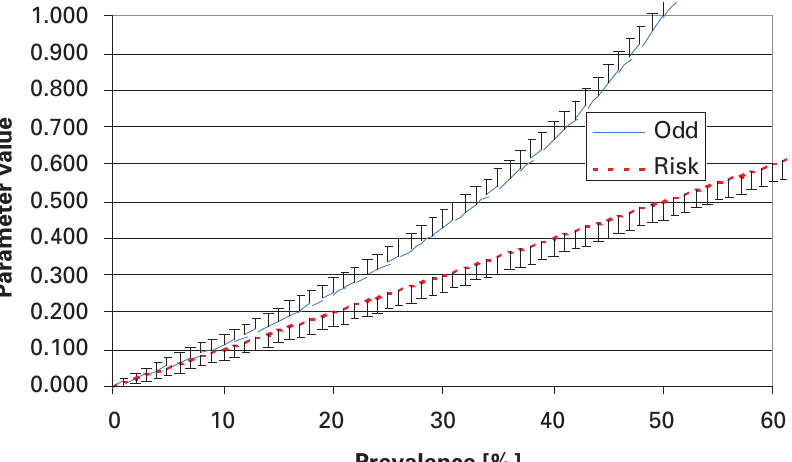
Figure 1 Relation between the odd (p / [1 – p]) and risk (p) according to prevalence showing the equality of both parameters below a prevalence of 10% and a statistically sig- nificant divergence above 30%. Value are shown with standard deviation for N =